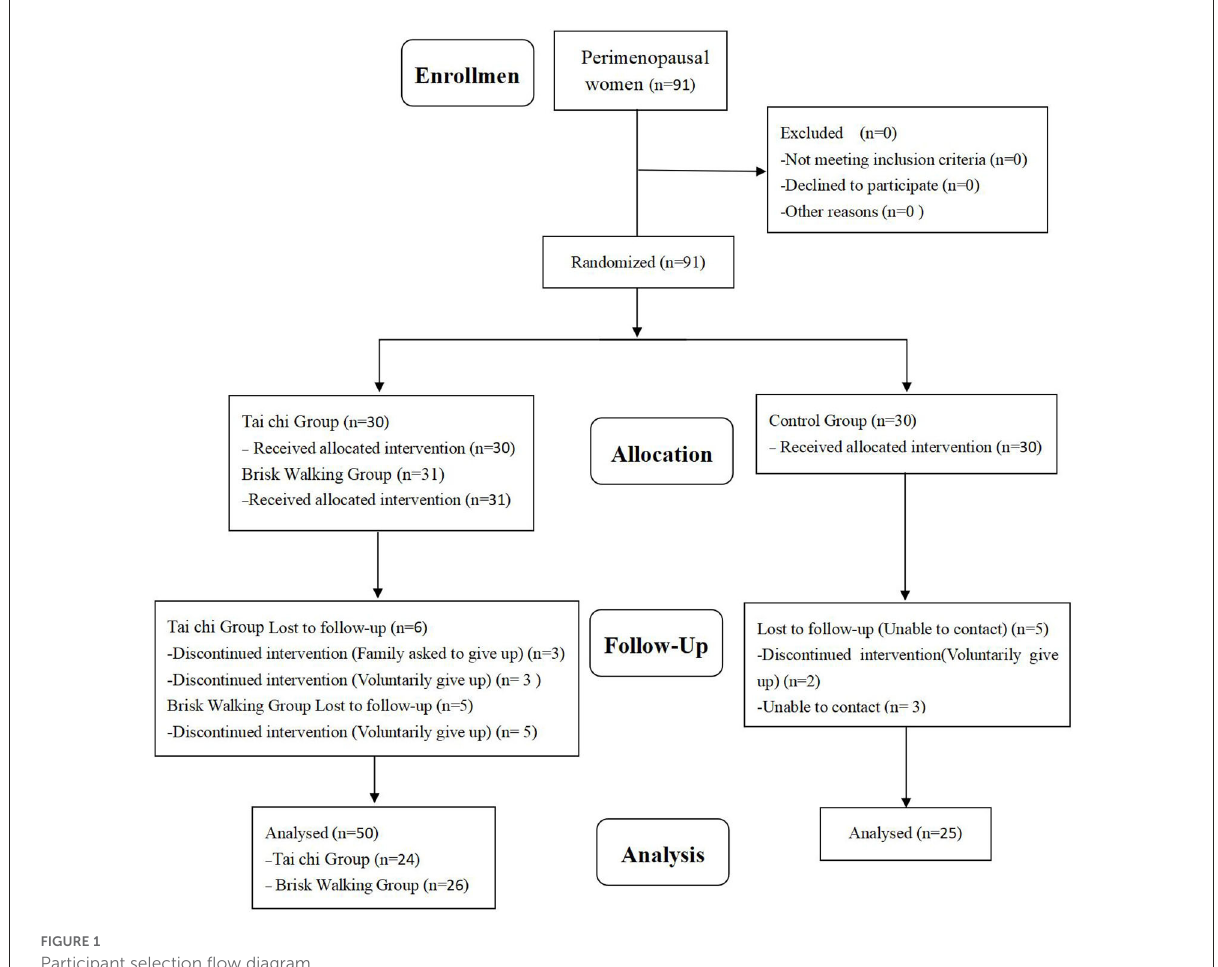
FIGURE1 Participant selection flow diagram.